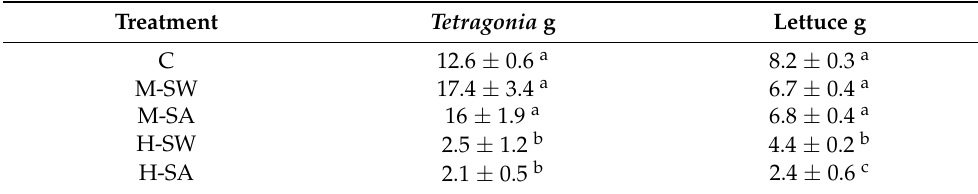
Table 2. The dry weight of whole plants at